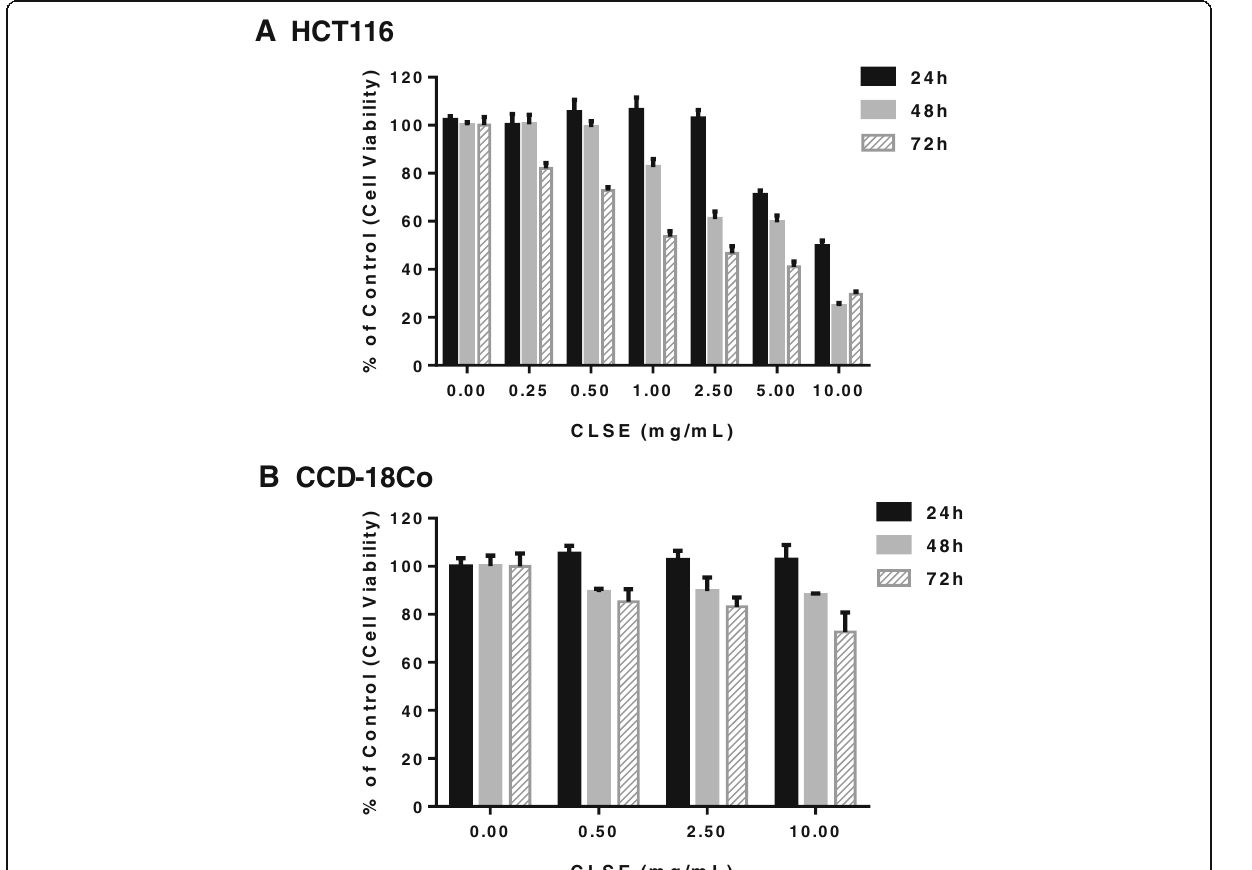
Fig. 1 Cytotoxic effect of CLSE on HCT116 and CCD-18Co cells. a, b . A Cell Counting Kit (CCK)-8 assay was used to measure HCT116 and CCD-18Co cells proliferation for 24 – 72 h after treatment with various concentrations of CLSE. Data are mean ± SD. CLSE, Coix lacryma-jobi var. ma-yuen Strapt sprout extract; SD, Standard